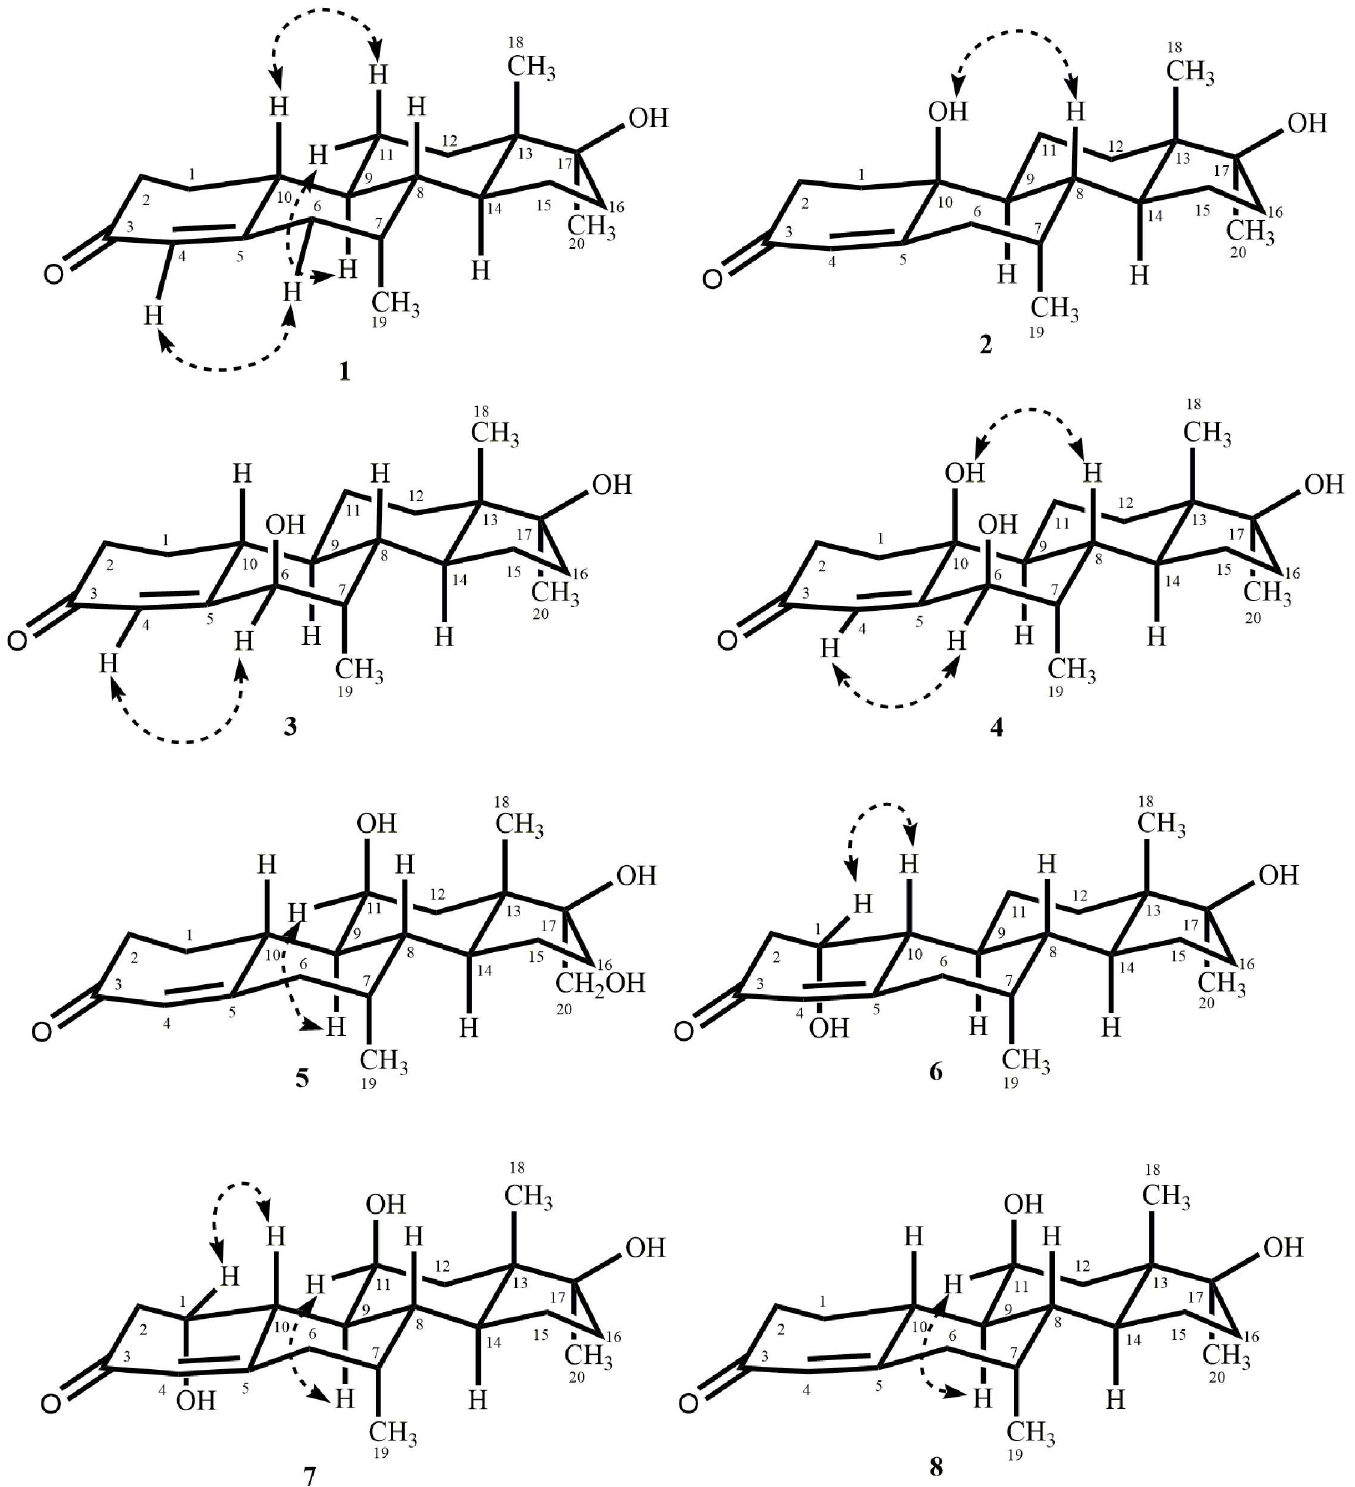
Fig 5. Key NOESY correlations of compounds